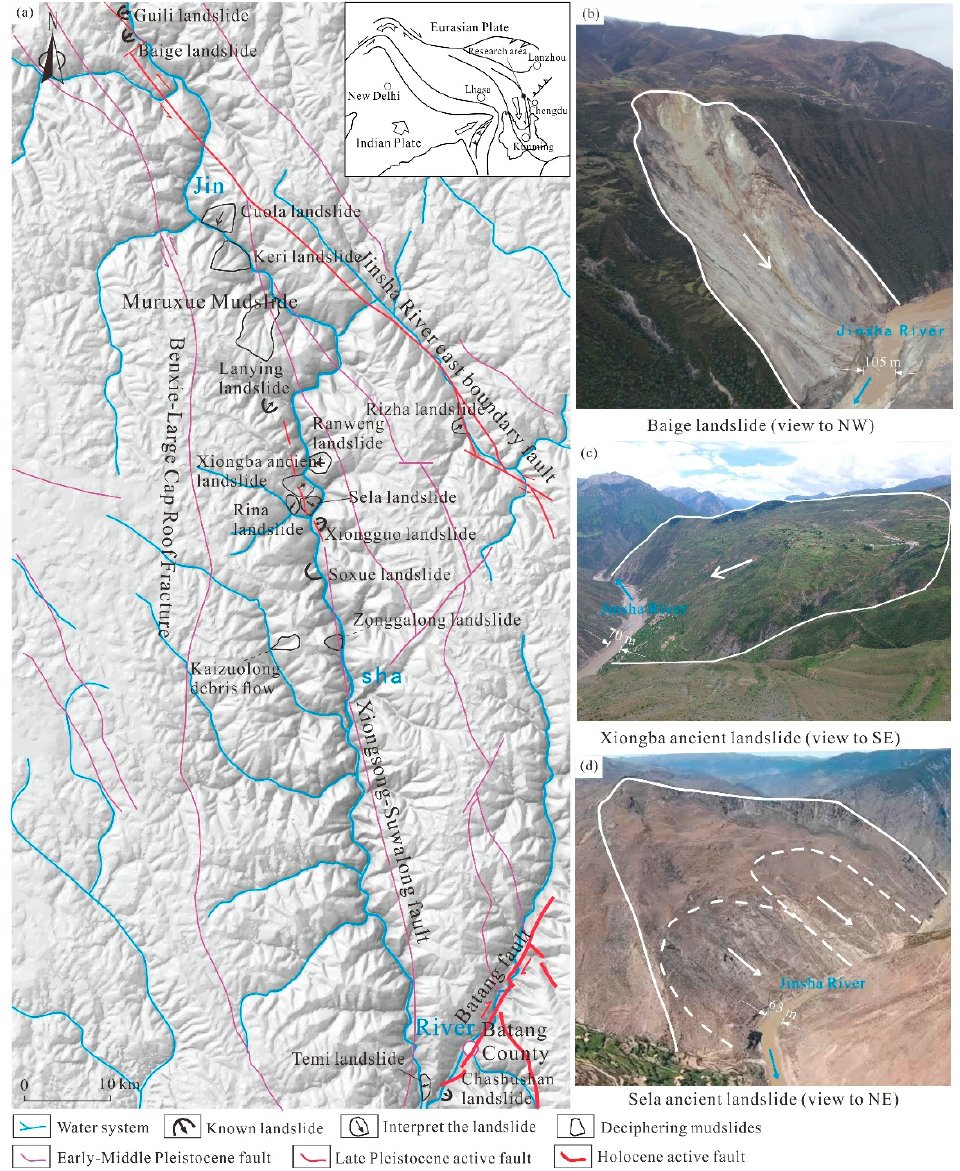
Figure 1. Typical giant landslide distribution along the Jinsha River fault zone. ( a )—The distribution map of the Jinshajiang fault zone; ( b )—Baige landslide (view to NW); ( c )—Xiongba ancient landslide (view to SE); ( d )—Sela ancient landslide (view to NE).